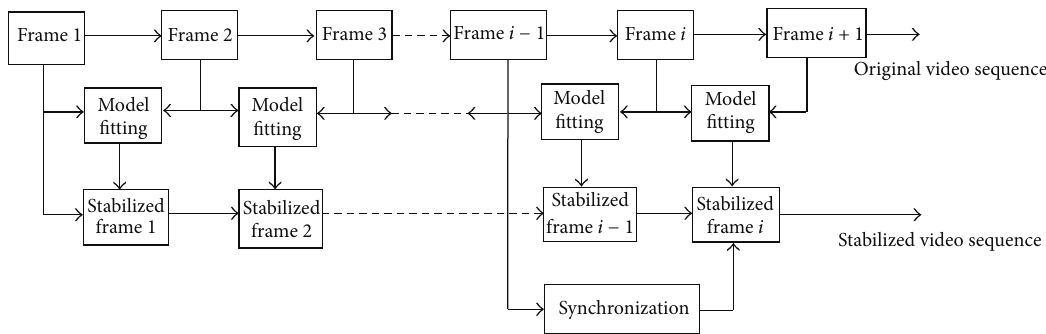
Figure 2: Compensation process to stabilize video